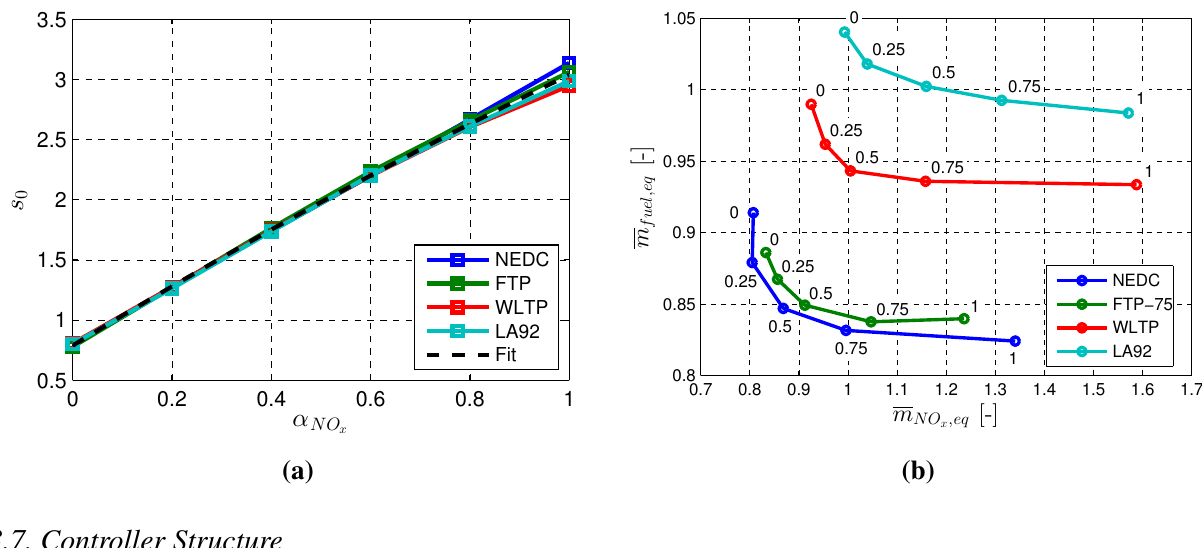
Figure 5. Relationship between the equivalence factors and the trade-off between the fuel consumption and NO emissions simulated for the New European Driving Cycle (NEDC), x Federal Test Procedure 75 (FTP-75), and California Unified Cycle (LA92) driving cycles: ( a ) relationship between the equivalence factors, α and s ; and ( b ) trade-off between the NO x 0 fuel consumption and NO emissions as a function of α x NO x